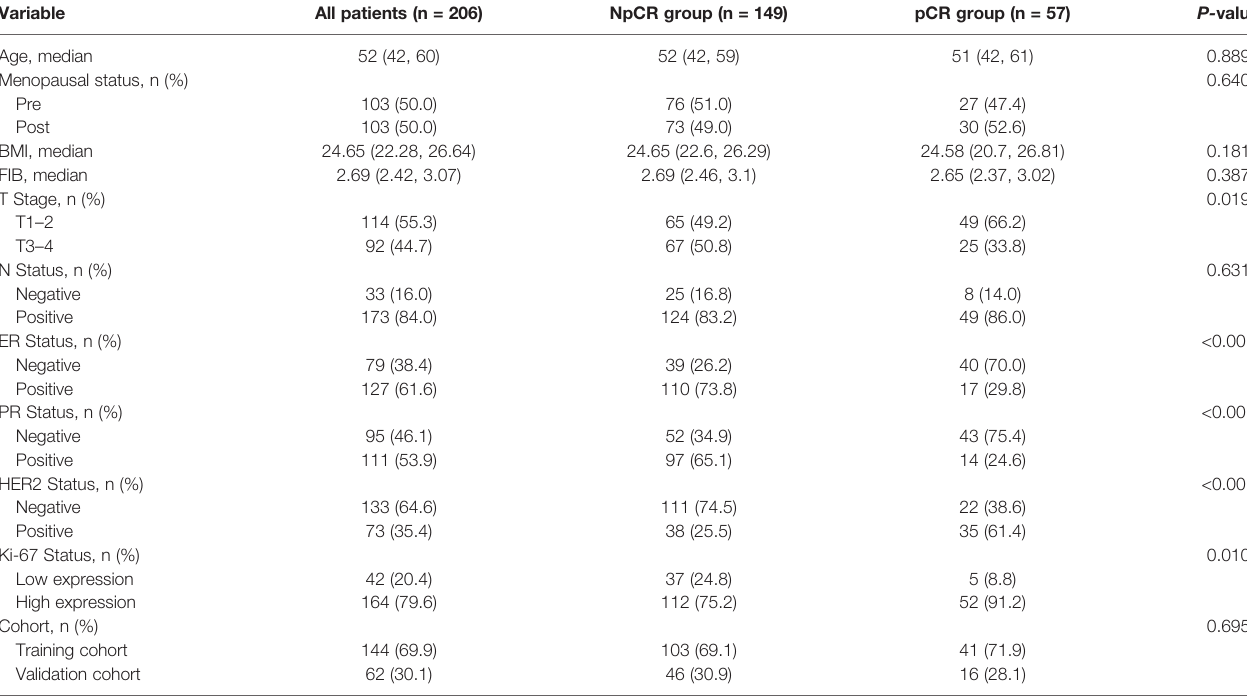
TABLE 1 | Demographic and clinical characteristics of the study cohort. Variable All patients (n =